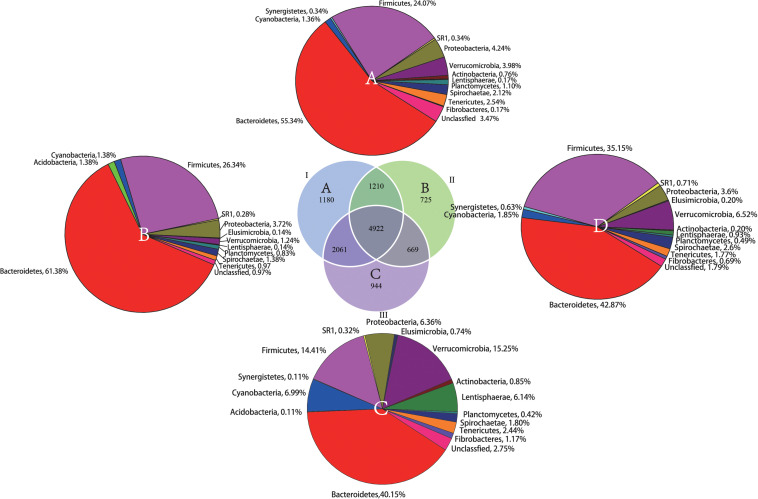
Shared and unique OTUs found in the rumen samples during the different phenological periods. The parenthetical numbers indicate total OTUs proportion in each group, whereas numbers in Venn diagram indicate unique (non-overlapping panels) and shared OTUs (overlapping panels). A total of 11,711 OTUs were detected. (A) unique OTUs annotated to the phylum level in the regreen stage, (B) unique OTUs annotated to the phylum level in grassy stage, (C) unique OTUs annotated to the phylum level in the withering stage. (D) The shared OTUs annotated to the phylum level among the three phenological periods.